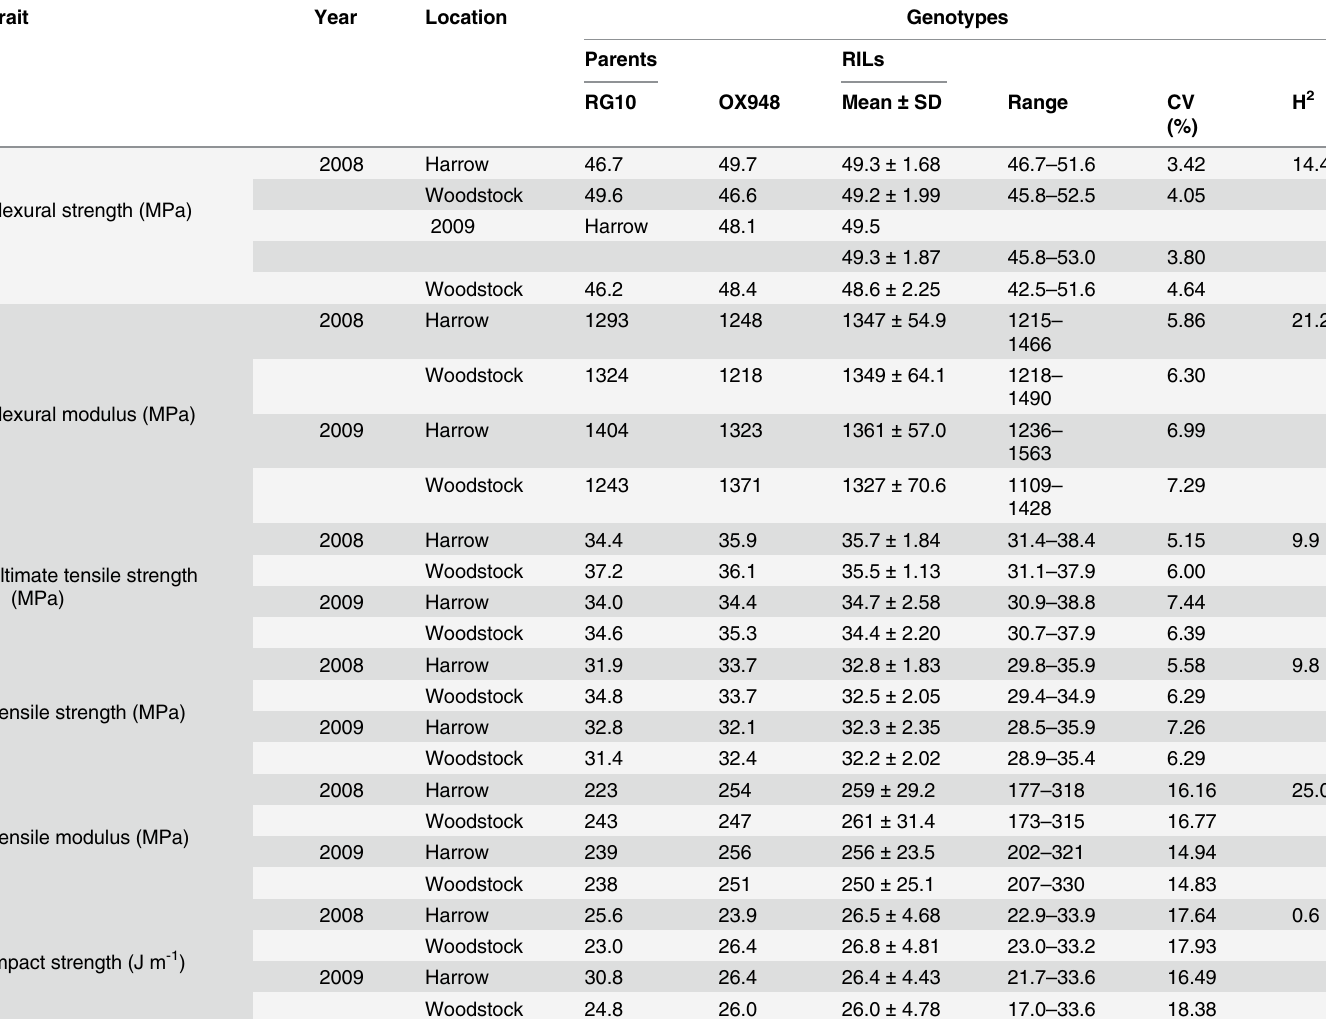
Table 2. Mechanical properties of soybean stem fiber/polypropylene (SS/PP) a composites.